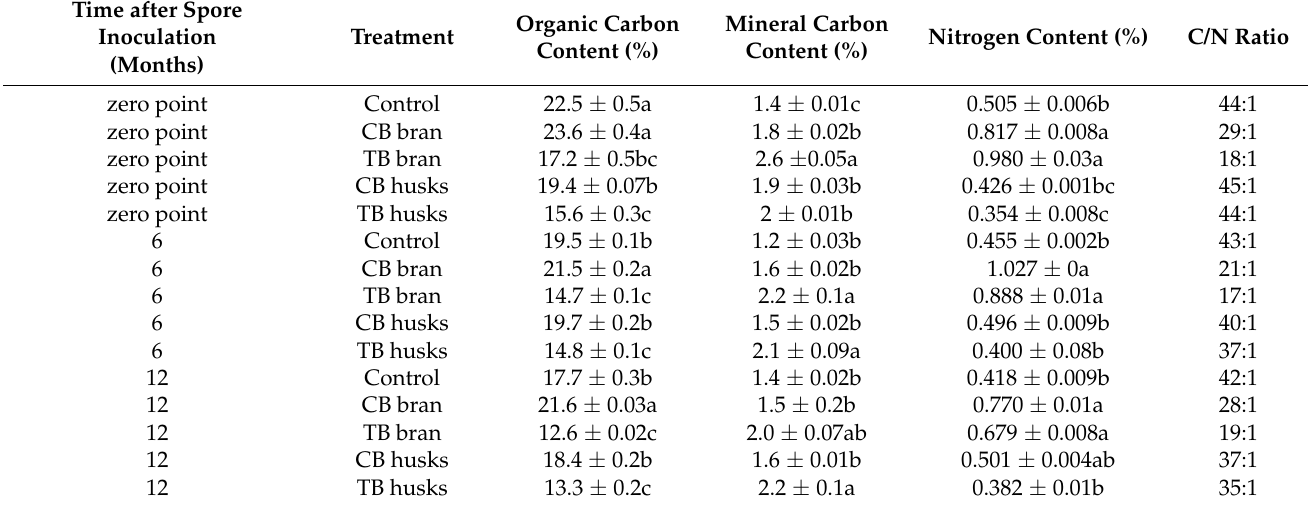
Table 1. Organic carbon, mineral carbon, and nitrogen content (average ± SD), and C/N ratio in substrates from different treatments, at zero point, 6 months, and 12 months after spore inoculation (CB = common buckwheat, TB = Tartary buckwheat). Different letters mark statistically significantly different results, according to the Tukey HSD test for all treatments and time points ( p ≤